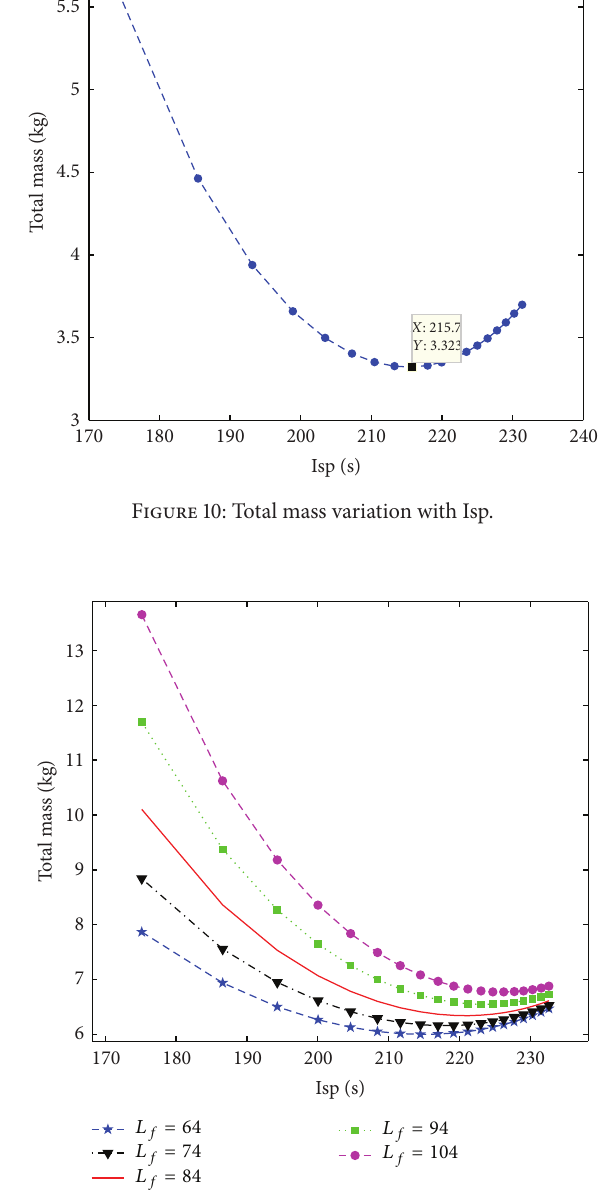
Figure 11: Movement of the minimum mass point by variation 𝐿 𝑓 .